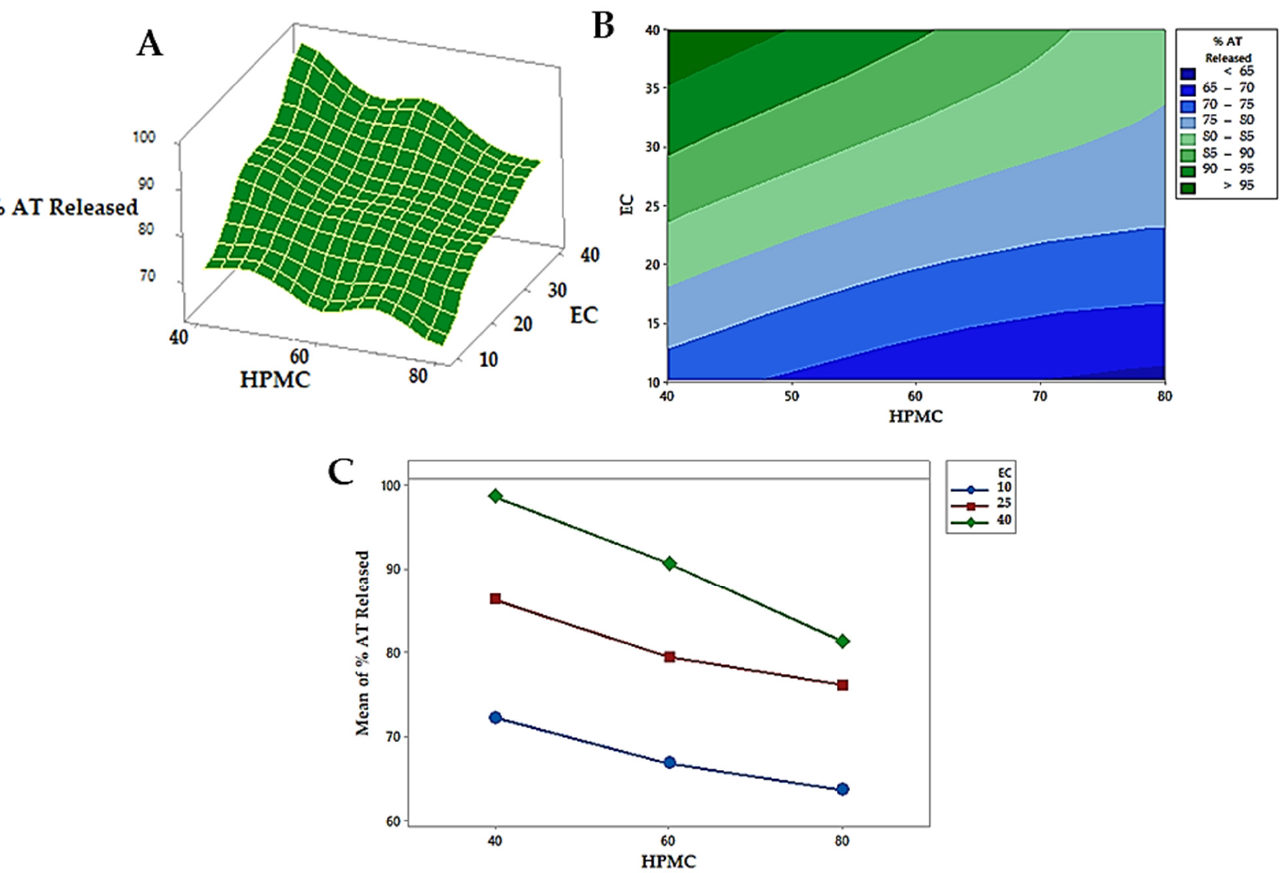
Figure 7. In vitro release profile of AT from the commercial and prepared mono tablets (mean ± SD, n = 3).